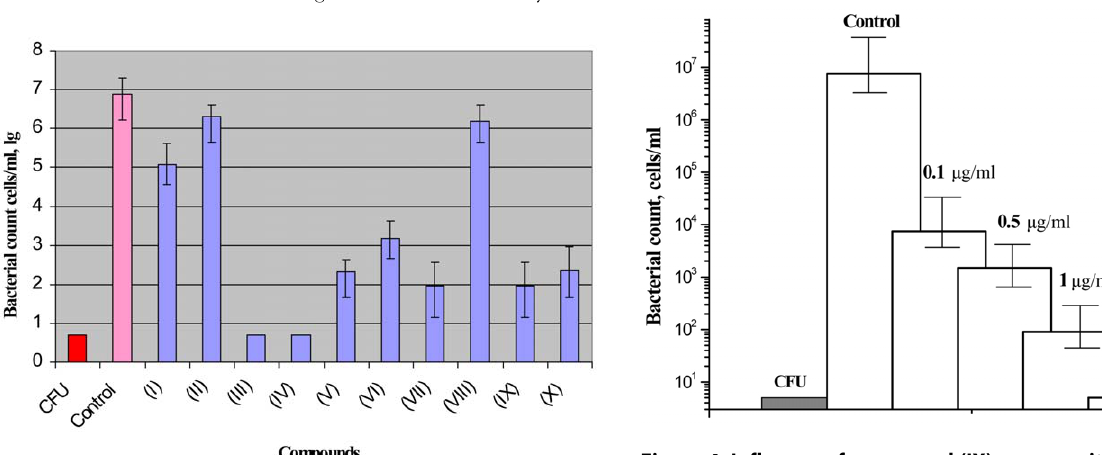
Figure 4. Influence of compound (IX) on resuscitation of ‘‘non- culturable’’ cells of M.smegmatis . Resuscitation of ‘‘non-culturable’’ cells of M. smegmatis obtained in the stationary phase (see ‘‘Materials and methods’’) was performed in the liquid medium by MPN assay as described in the ‘‘Materials and methods’’. Plates with resuscitating cells were incubated for 2 weeks at 37 u C with shaking at 100 rpm. Filled column – CFU count before resuscitation. Opened columns – MPN counts. Concentrations of compound (IX) added to the resuscitation medium are shown above each column. Bars represent (95%) confidence limits for MPN and 6 SD for